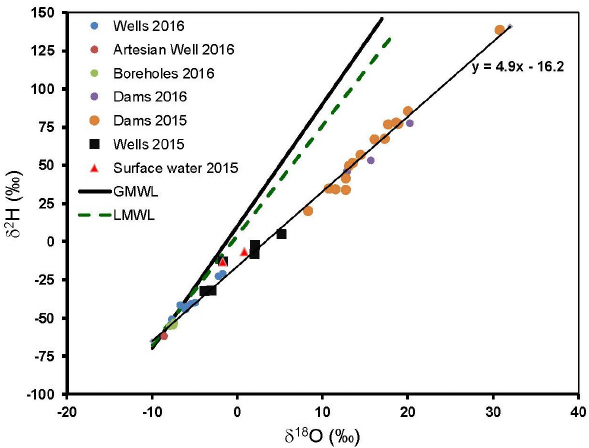
Figure 2. Plot of the stable oxygen isotopes ( δ 18 O) vs. hydrogen ( δ 2 H) for water samples from the Cuvelai-Etosha Basin. GMWL is the global meteoric water line and LMWL is the local meteoric water line.